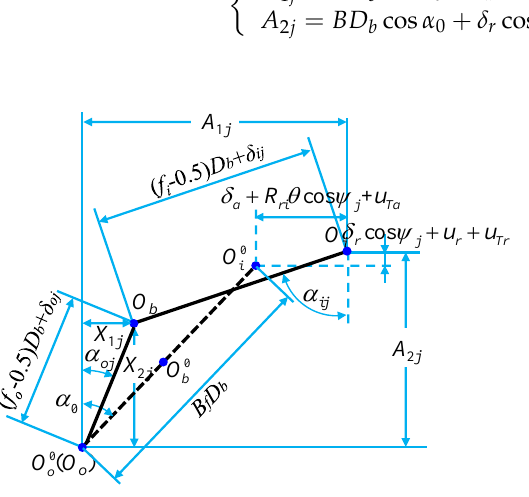
Figure 9. The contact angles, deformations, and displacements for the ball – raceway contacts at azimuth ψ j with the working load, centrifugal force, and thermal deformation.